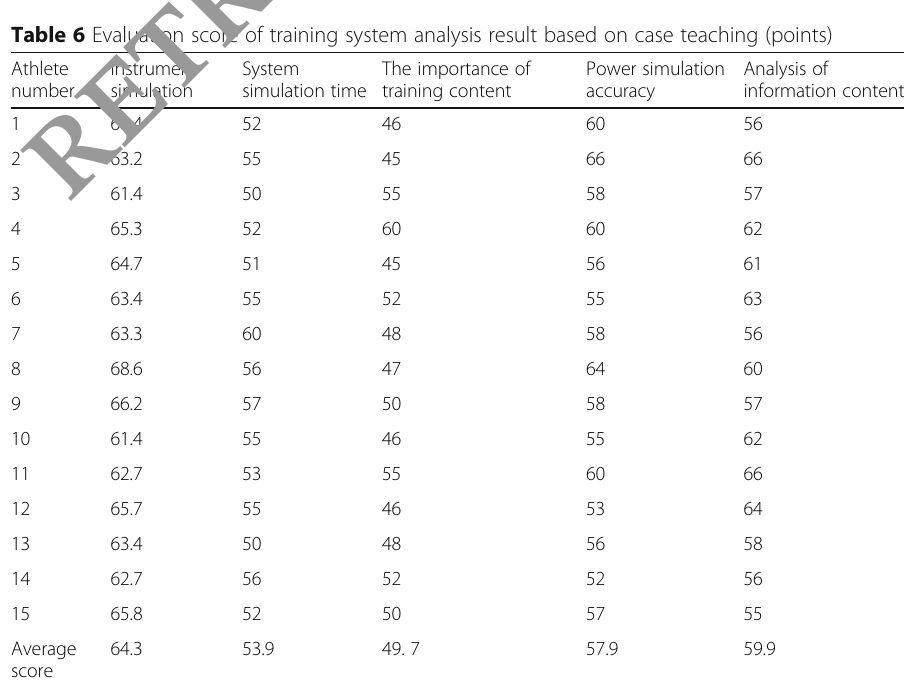
Table 6 Evaluation score of training system analysis result based on case teaching (points) Athlete number